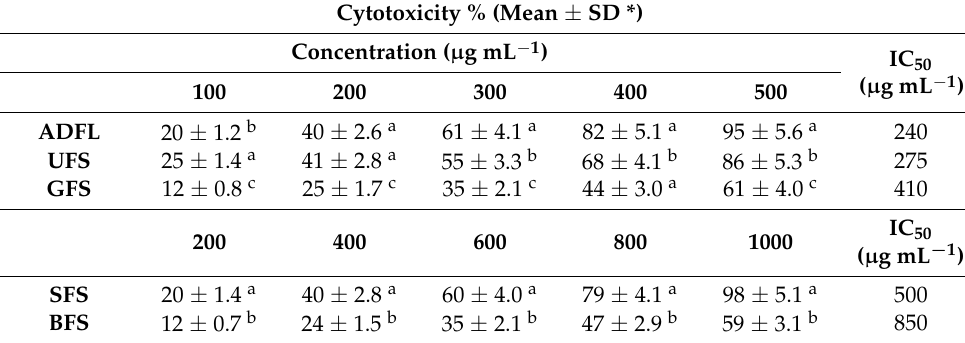
Table 2. Anti-proliferative activity and IC 50 ( µ g mL − 1 ) values of ethanolic crude extracts of each air-dried fenugreek leaves (ADFL), untreated fenugreek seeds (UFS), germinated fenugreek seeds (GFS), soaked fenugreek seeds (SFS), and boiled fenugreek seeds (BFS) against colon carcinoma cell line (HCT-116).